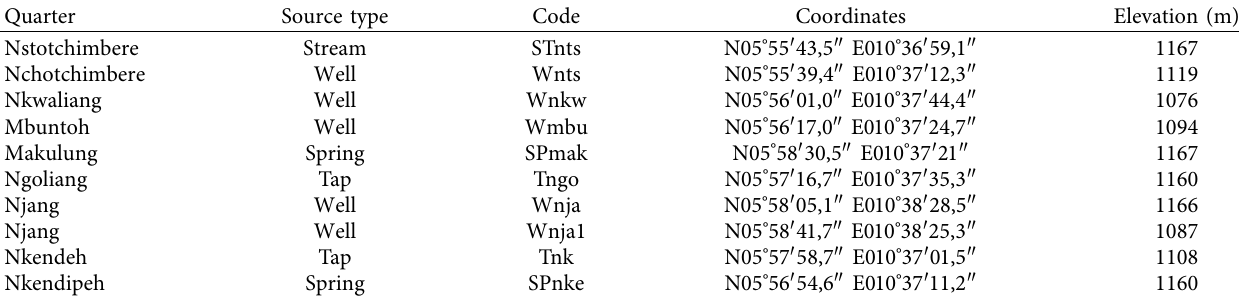
Table 1: Quarters, source type, sample codes, and geographical coordinates of sampling